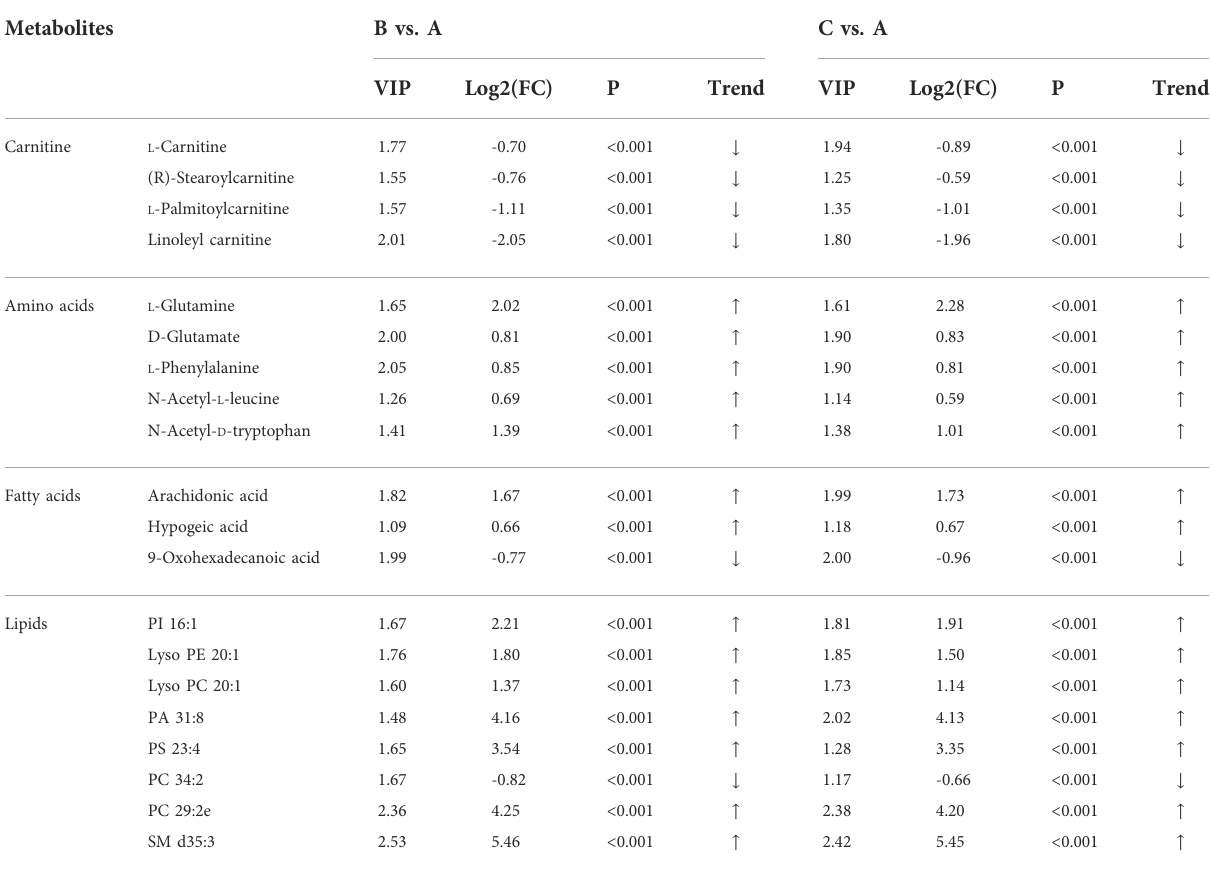
TABLE 3 List of statistically signi fi cant metabolites in A vs B and A vs C comparisons. Metabolites B vs. A C vs. A VIP Log2(FC) Trend